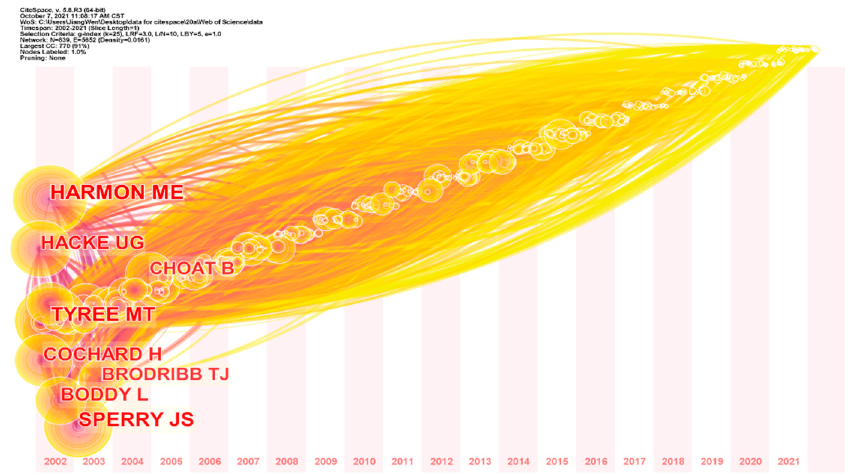
Figure 8. The time-zone view of the co-cited author. Figure 8. The time ‐ zone view of the co ‐ cited author.